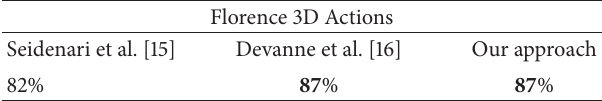
Table 7: Comparing of our method with the others on Florence 3D Actions